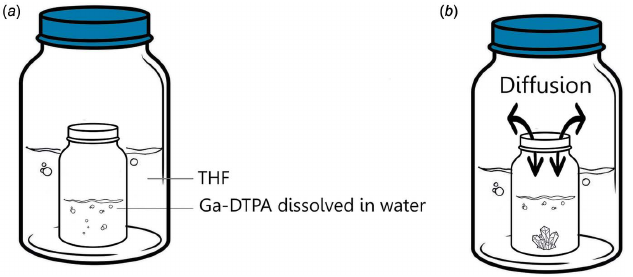
Figure 4 Vapor liquid diffusion technique illustration. ( a ) a HPLC vial containing Ga-DTPA dissolved in water was placed inside a bigger vial. The closed bigger vial contained THF. ( b ) THF diffused slowly into the small vial. After four weeks, visible Ga-DTPA crystals were formed.